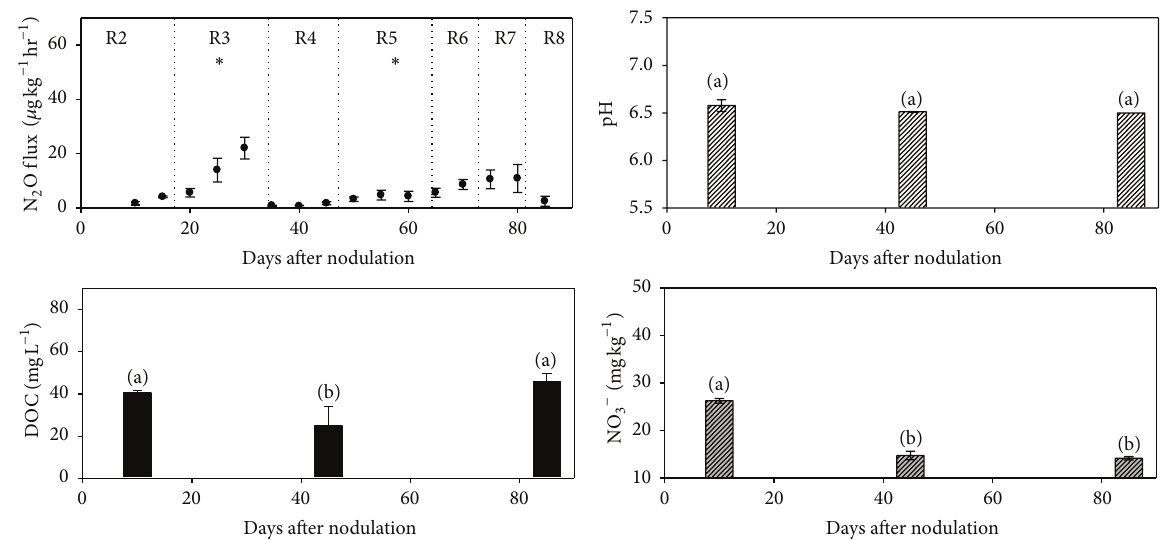
Figure 2: Temporal dynamics of N 2 O flux ( 𝜇 gkg −1 hr −1 ), soil pH, DOC (mgL −1 ), and NO 3− -N (mg kg −1 ) of NIS treatments. Different lower case letters indicate a statistically significant difference at 𝛼 = 0.05. R2: full flowering; R3: beginning pod; R4: full pod; R5: beginning seed; R6: full seed; R7: beginning of maturity; R8: full maturity. ∗ Symbol indicates application of mineral N fertilizer. Means of 3 replicates with standard error.